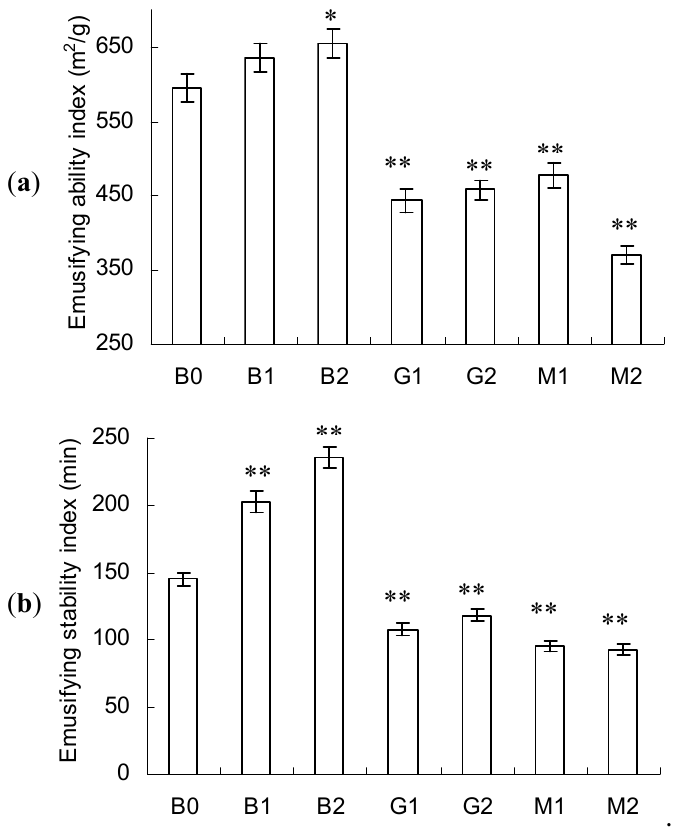
Figure 4. Emulsifying ability index ( a ) and emulsifying stability index ( b ) of BSA, BSA–glucose and BSA–mannose at intensities 10 and 20 kV/cm. Data are mean ± standard deviation, n = 3. * p < 0.05, ** p < 0.01 versus control (B0).